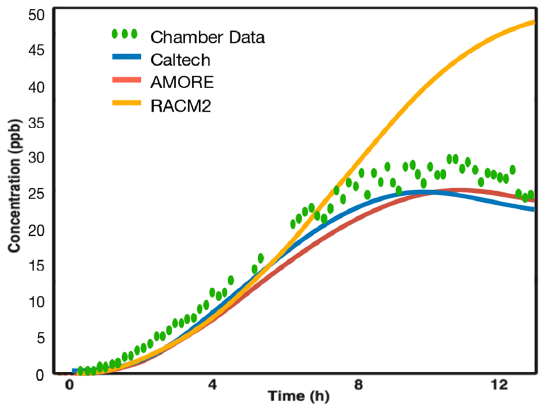
Figure 8. IEPOX concentration comparison between chamber data from Paulot et al. (2009) and F0AM box model simulations us- ing the reported chamber conditions. The Caltech full mechanism closely matches the measured values, as does the AMORE-Isoprene